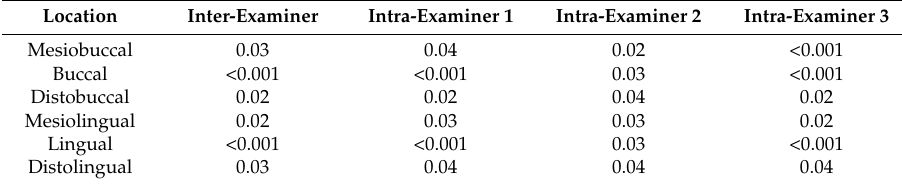
Table 1. Examiner Calibration Data ANOVA is used to identify no significant differences between a panel of examiners. T-test is used to identify no significant differences between time 1 and time 2 of each of the